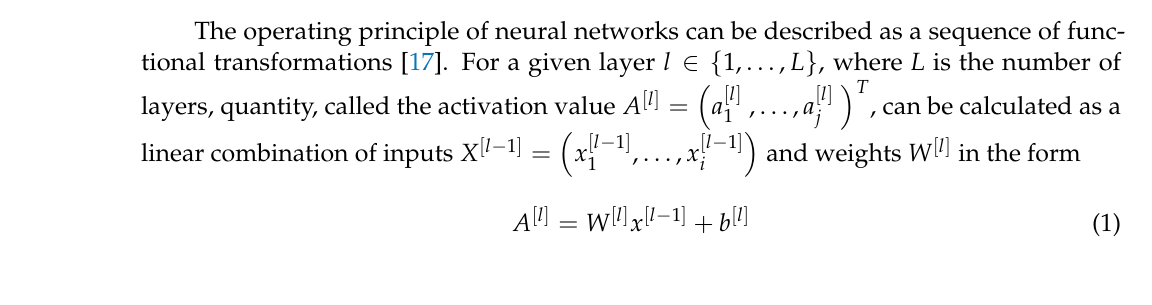
Figure 1. General neural network model structure.